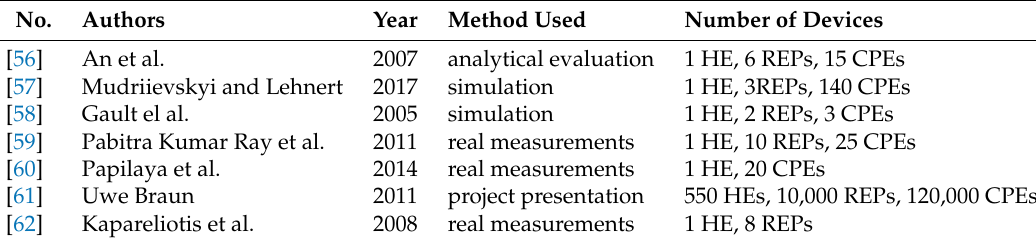
Table 1. State of the